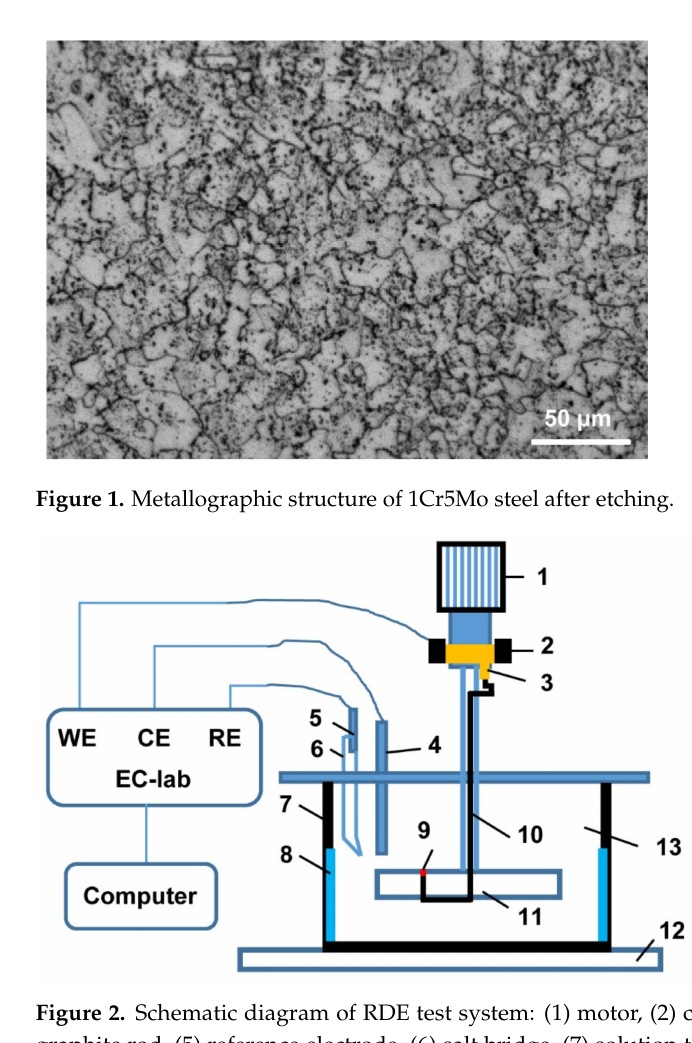
Figure 2. Schematic diagram of RDE test system: (1) motor, (2) carbon brush, (3) copper ring, (4) graphite rod, (5) reference electrode, (6) salt bridge, (7) solution tank, (8) baffle, (9) specimen, (10) copper wire, (11) rotating disk, (12) solution tank holder, and (13) solution.